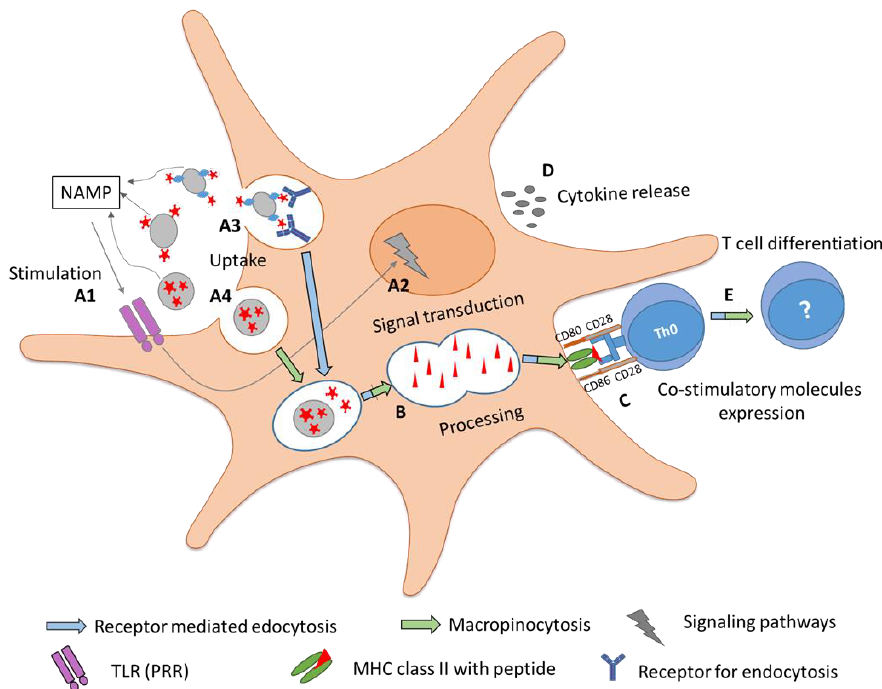
Figure 4. Adjuvanticity of nanoparticles along with the events associated in developing immune tolerance. In event A1, stimulation of immune responses by nanoparticles can be associated with NAMPs that can induce (event A2) signaling cascades, leading to the transcription of maturation genes. Nanoparticles can increase the uptake of allergen mainly by (event A3) macropinocytosis or (event A4) receptor-mediated endocytosis, based on the physicochemical properties of nanomaterial. In event B, nanoparticles associated with allergens can increase the proteolytic processing and lead to maturation of APCs marked by enhanced (event C) co-stimulatory molecule expression and (event D) cytokine release (IL-10, TGF-β), which further triggers (event E) T cell activation and differentiation.